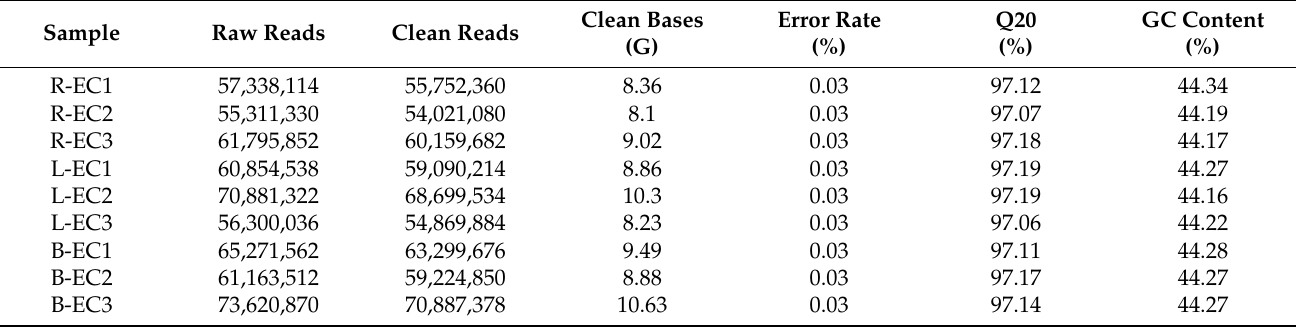
Table 1. Sequencing data evaluation and statistical results of different somatic embryogenesis potential cell lines of Korean pine.